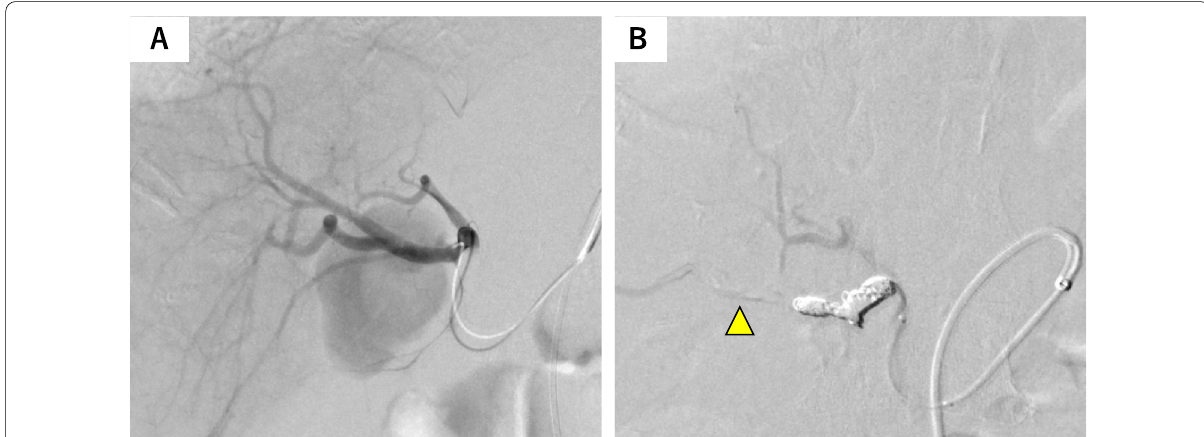
Fig. 2 Angiography findings on admission and after transcatheter arterial embolization (TAE). Digital subtraction angiography from the right hepatic artery indicated a 50 32-mm pseudoaneurysm derived directly from the right hepatic artery or the cystic artery ( A ). We isolated the × pseudoaneurysm by embolizing its proximal and distal portions of the pseudoaneurysm ( B ). The bleeding was stopped, and it was confirmed that the distal end of the right hepatic artery was supplied by the collateral blood flow of the middle hepatic artery (yellow